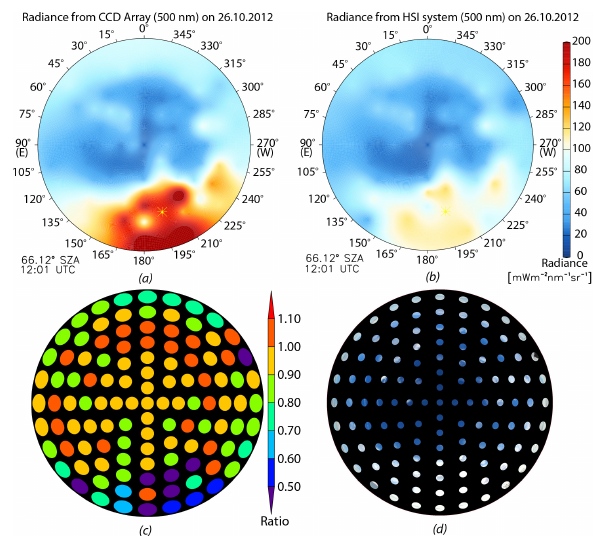
Figure 6. Spectral radiance measured at the wavelength 500nm by the CCD spectroradiometer (a) and HSI system (b) on 26 October 2012 at 12:01UCT (66.12 ◦ of SZA) under intermediate sky. Plot (c) shows the ratio between the computed spectral radiance from the HSI system and the measured spectral radiance by the CCD spec- troradiometer (HSI system/CCD spectroradiometer). Although the FOV of the scanning pattern used is 5 ◦ (see d ), the scanning points showing the ratio are plotted with a FOV of 10 ◦ to achieve a bet- ter illustration. The synchronized HSI image showing the 5 ◦ FOV pattern of the scanning points from the CCD spectroradiometer is illustrated in (d)